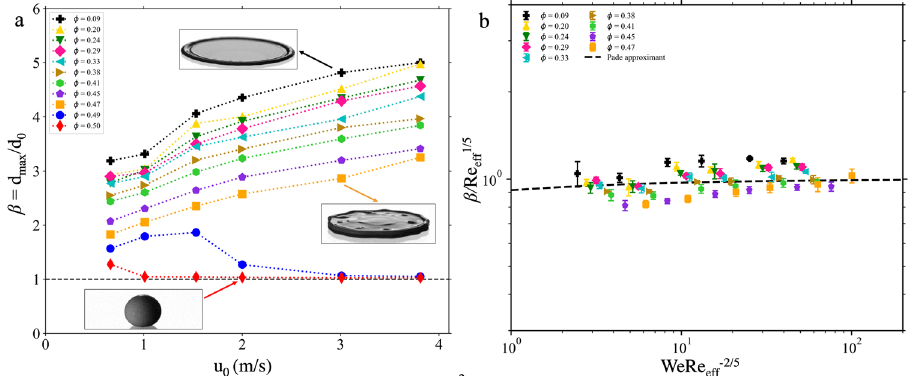
Fig. 4 Quantifying maximum drop spreading. a Normalised maximum diameter, β = d max / d 0 , as a function of u 0 for various volume fractions ϕ . For ϕ ≥ 0.49 and high impact velocities, β drops to 1, indicating the drop does not spread. Insets show representative snapshots of simple spreading (upper), localised solidi fi cation (middle), and bulk solidi fi cation (lower). Dotted lines are guides to the eye, and the dashed black line indicates β = 1. b β = Re 1 = 5 eff for ϕ ≤ 0.47, plotted against the dimensionless parameter WeRe (cid:2) 2 = 5 fi rst-order Padé approximant as reported by Laan et al. 8 [Eq. eff . The dashed black line is the (3)] for Newtonian fl uids, fi t to our data. Considering the strongly shear-thinning nature of our suspensions, the data shows a good agreement with the Newtonian